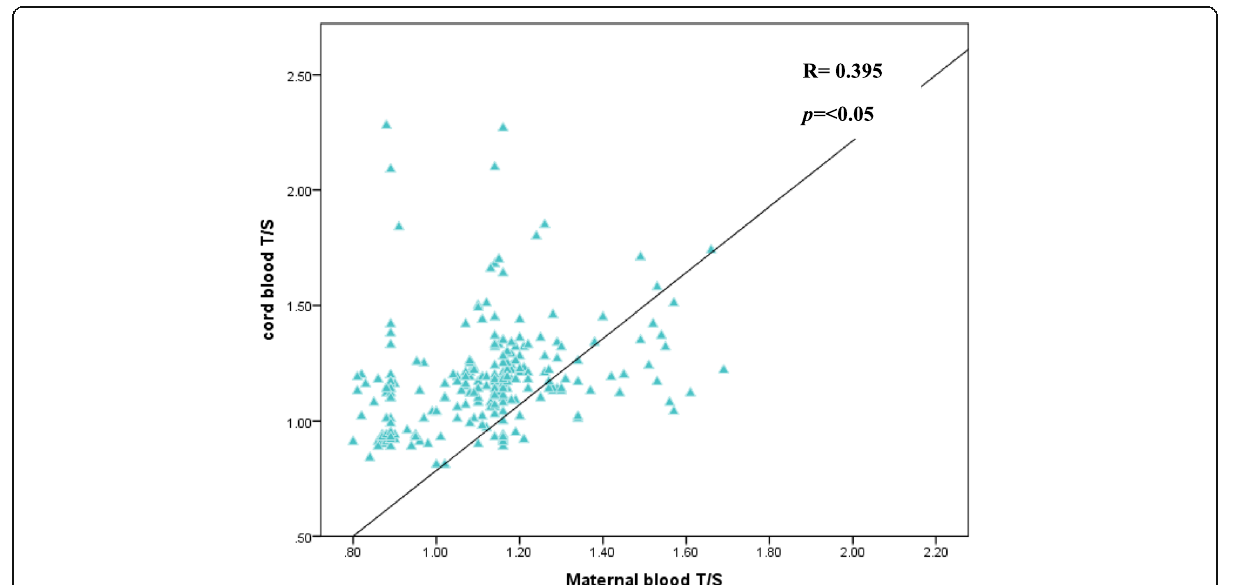
Fig. 1 Scatter plot between cord and maternal blood T/S ratio. Spearman ’ s correlation was used to calculate R and p